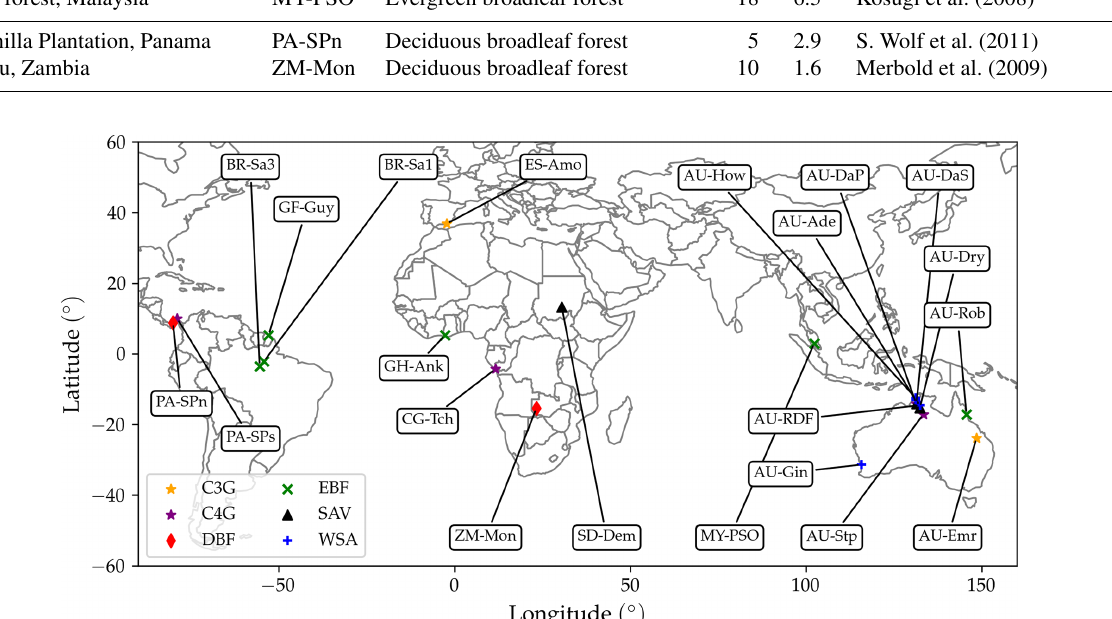
Figure 6. FLUXNET sites selected for model evaluation. Different symbols indicate different land cover types. The sites are labelled accord- ing to their site code (Table